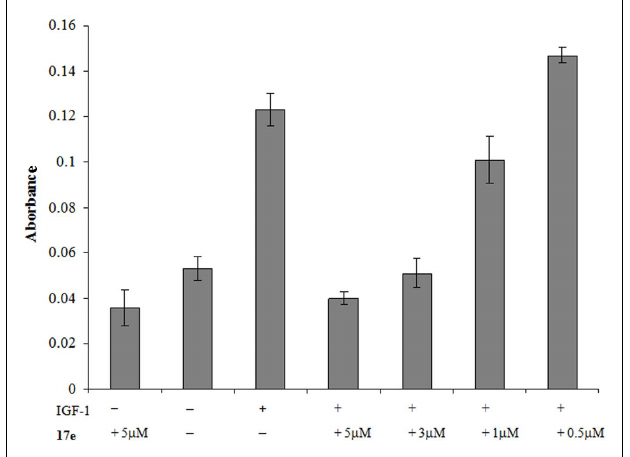
FIGURE 7 | PC-3 cells were used in a chemotaxis experiment to measure cell migration. The absorbance represents the amount of stained cells that migrated through the 8- μ m membrane using insulin-like growth factor 1 as the attractant. Error is represented as SEM, n = 5.